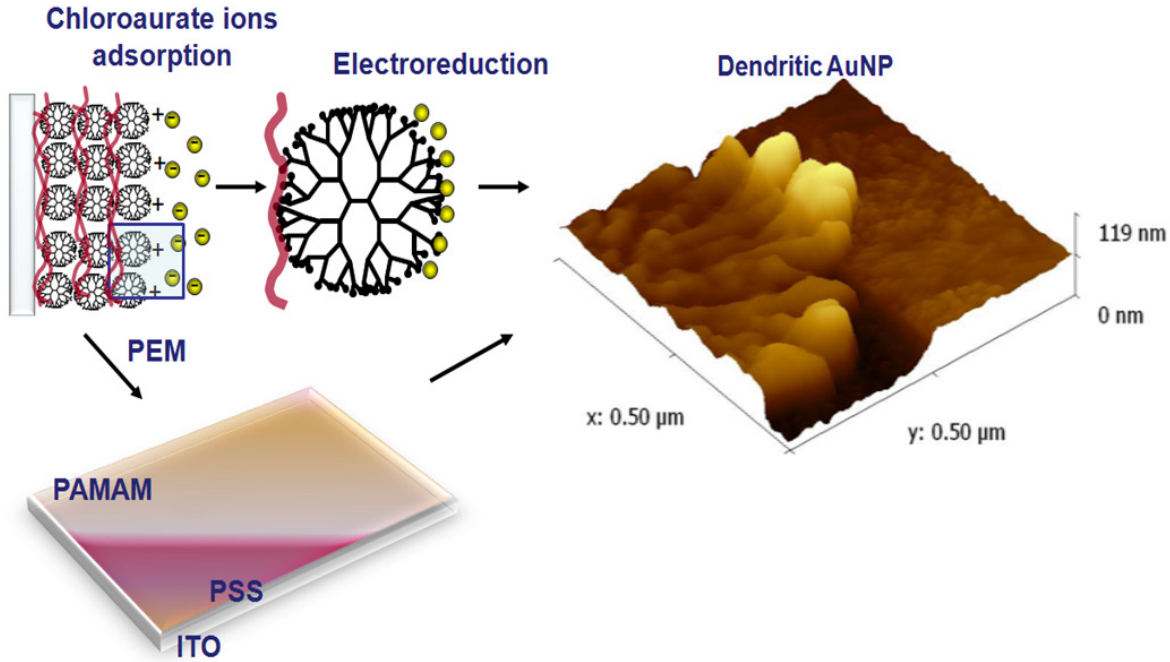
electrodes with adsorption of 2 - 2